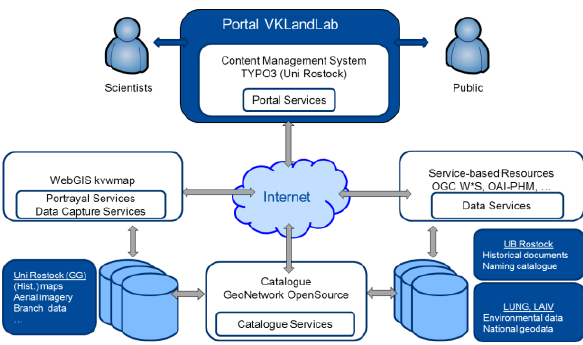
Figure 2. Portal components with related services and data